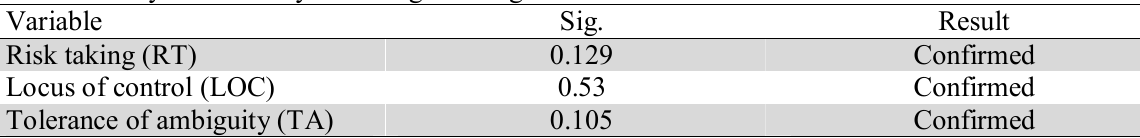
The summary of normality test using Kolmogorov–Smirnov Variable Risk taking (RT) Locus of control